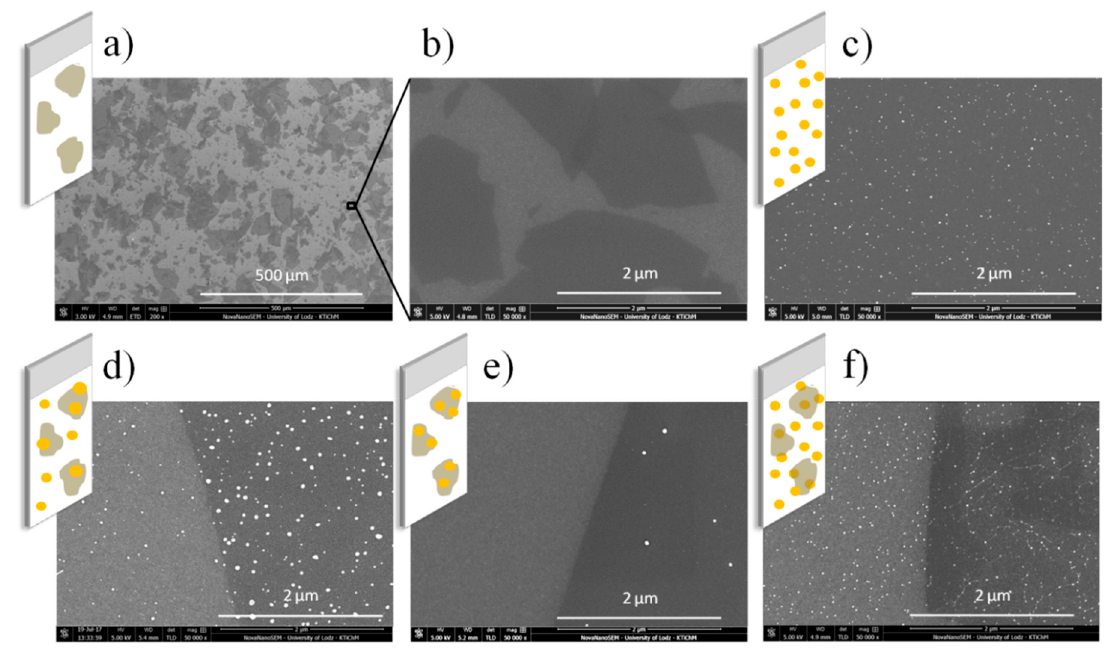
Figure 4. SEM images and related schemes of ( a ) and ( b ) TiO 2 -GO (graphene oxide), ( c ) TiO 2 -AgNSs (silver nanostructures), ( d ) TiO 2 -GO-AgNSs, ( e ) TiO 2 -(GO-AgNSs) and ( f ) TiO 2 -AgNSs-GO.